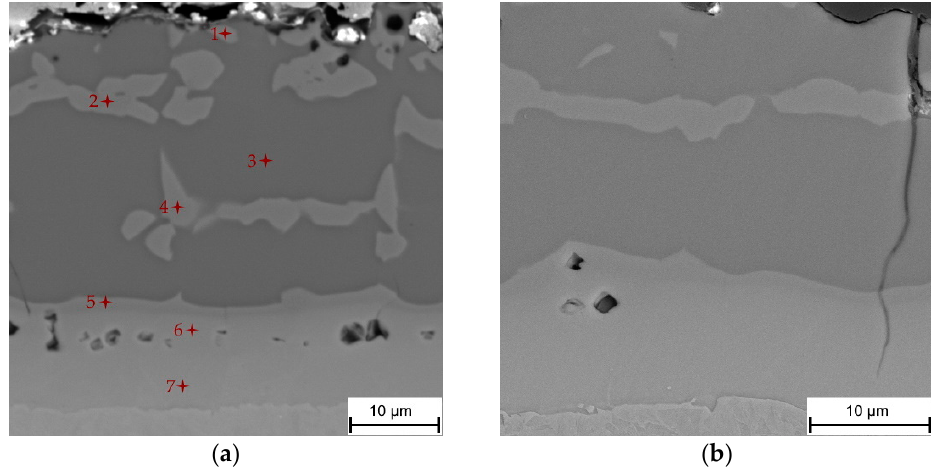
Figure 4. The microstructure of the Al-Si coating on the die-quenched 22MnB5 boron steel: ( a ) cross-section and ( b ) a detailed image of the microcrack reaching into the interdiffusion layer.